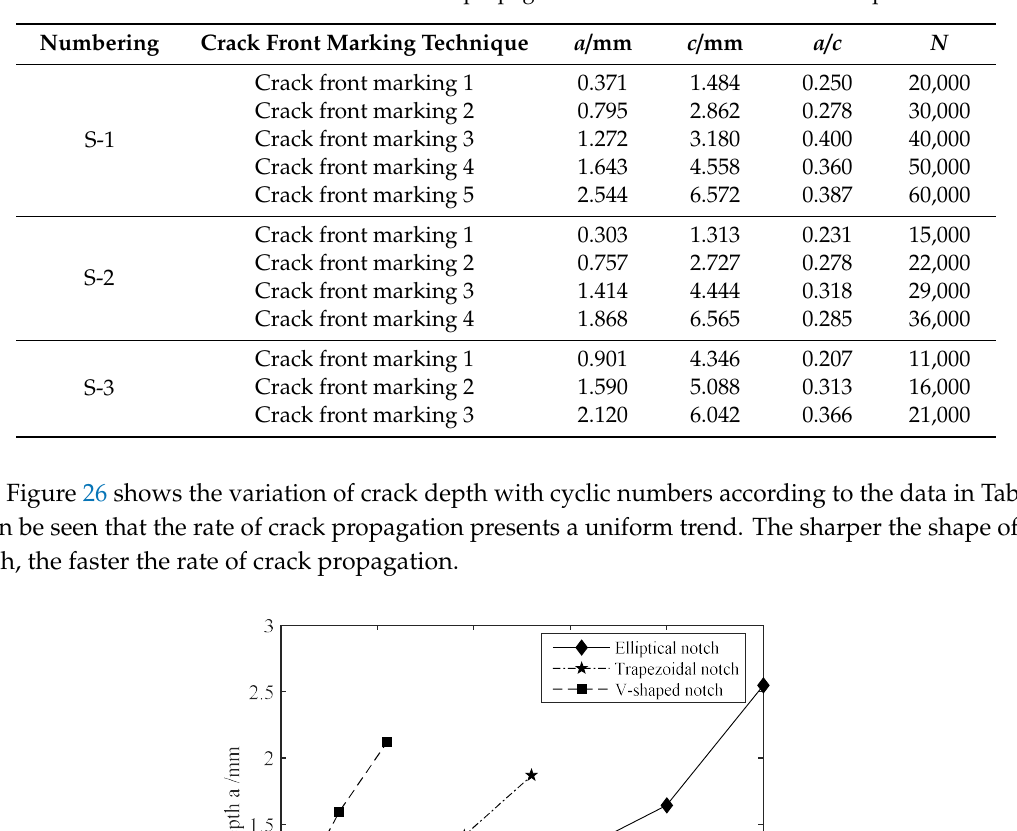
Table 7. Test data of steel wire crack propagation with notches of di ff erent shapes.